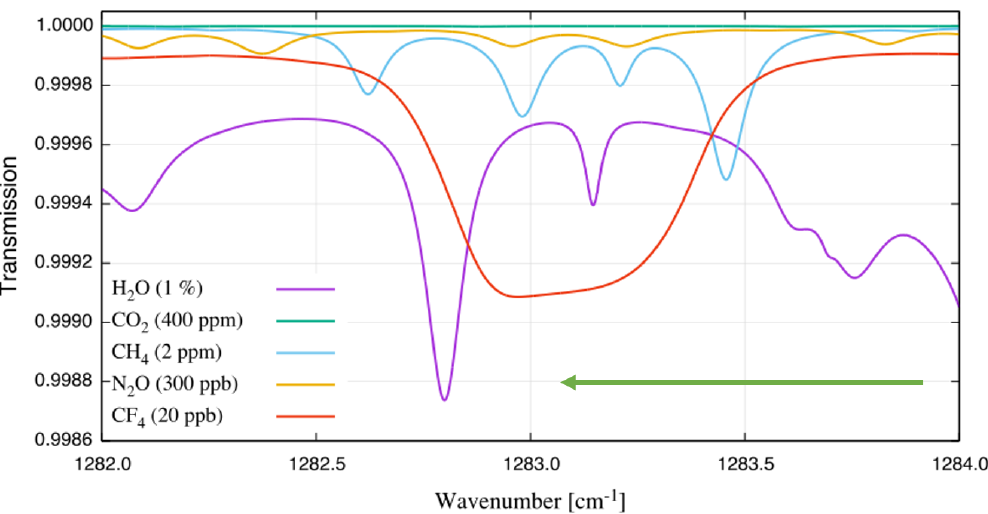
Figure 1. Transmission simulation of ambient air and tetrafluoromethane using the HITRAN and HITEMP databases. The simulation is performed for an optical path length of 1 m, ambient pressure and a gas temperature of 125 ◦ C. The gas components and their concentrations are provided in the